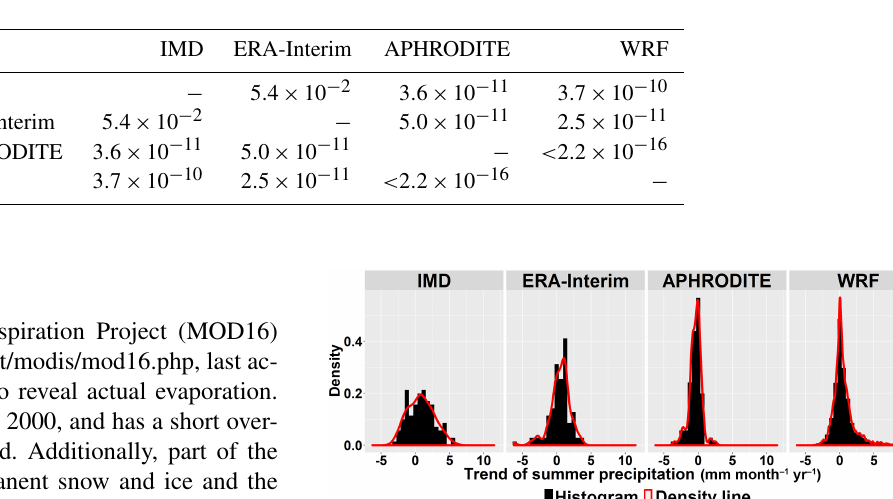
Table 3. P value of the tailed Kolmogorov–Smirnov test on differences of on annual precipitation (mmyear − 1 ) among the datasets. The p value indicates strong evidence against the null hypothesis. It is typically to reject the null hypothesis, which is two datasets are the same here, when the p value is not greater than 0.05.